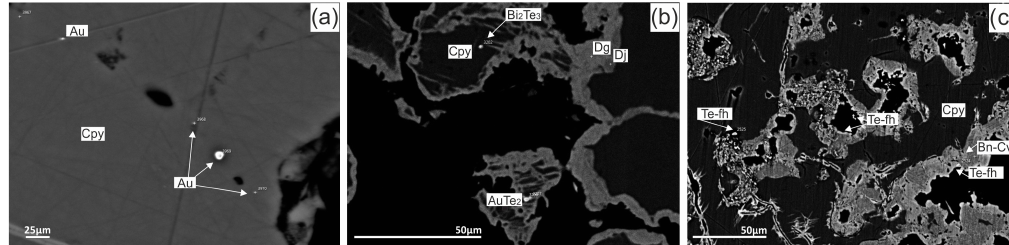
Figure 6. BSE photographs. Au and Te minerals of chalcopyrite-sphalerite chimneys (35.7 kyr). ( a ) Native gold (Au) associated with chalcopyrite (Cpy) grains; ( b ) Calaverite (AuTe 2 ) in the Cu-sulphide (digenite-jarleite). Rare tellurobismuthite (Bi 2 Te 3 ) associated with chalcopyrite; ( c ) Abundant Te rich fahlore (Te-fh) in the covellite.